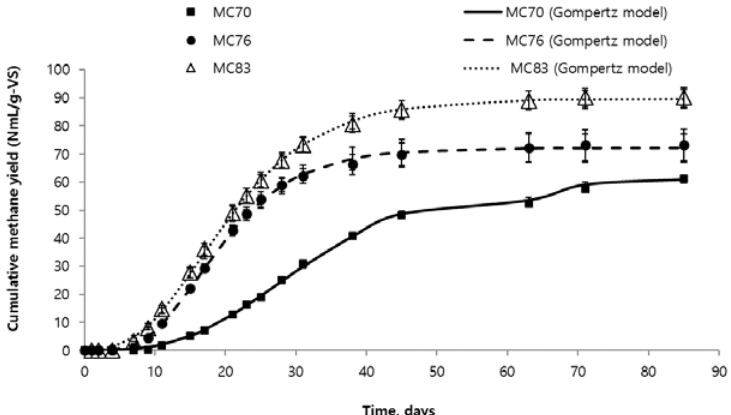
Figure 4. Influence of initial feedstock moisture content on cumulative methane yields from dairy manure. Digesters containing non-amended manure containing 70% MC (MC70) and manure amended to 76 and 83% MC (equivalent to the water holding capacity of dairy manure) (MC76 and MC83, respectively) were incubated at 37 ° C for 85 days. Values are means (± SE) of three replicates. Experimental and model-derived results are shown.